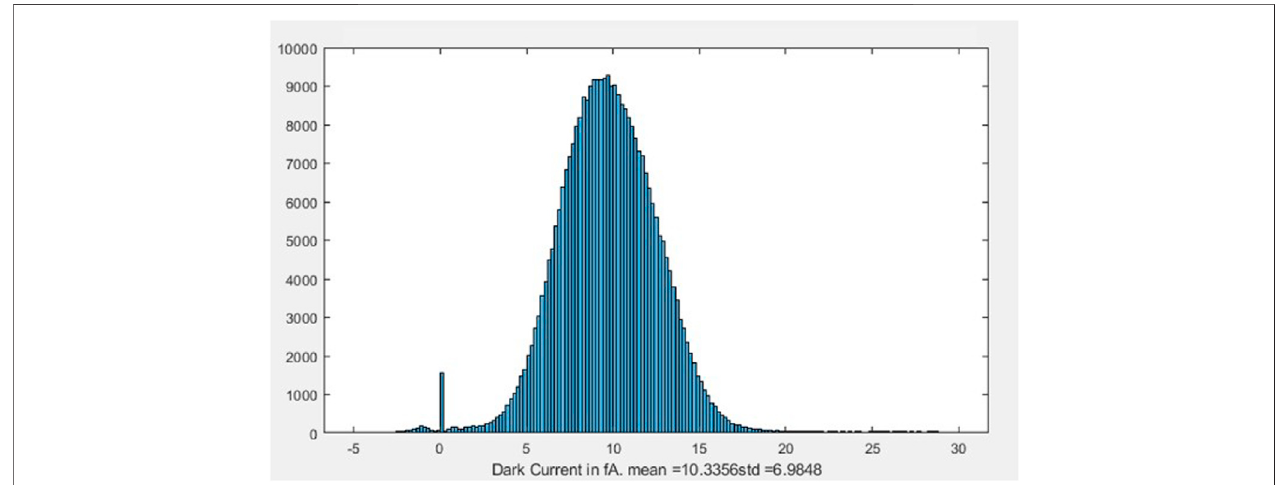
FIGURE 7 | Histograms of the dark current at 33 ° C.